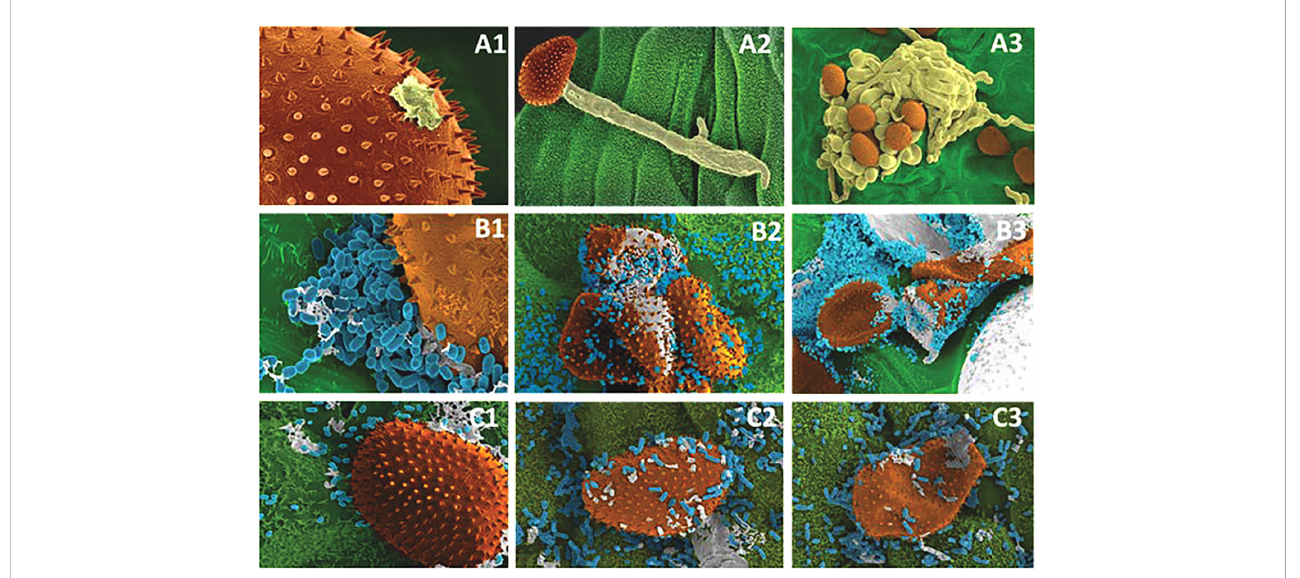
FIGURE 6 Potential antagonistic effect of Bacillus subtilis (AFS032321) and Pseudomonas_E chlororaphis (AFS000009) against Phakopsora pachyrhizi urediniospores. Healthy urediniospores: (A1) urediniospore on the surface of soybean leaf disk showing an area where the germ tube will come out [8,000X], (A2) germinated urediniospore with developed germ tube ready to penetrate soybean leaf interior [1,500X], (A3) sporulation (9 days after inoculation) [800X]. Bacterial isolates AFS000009 (B) and AFS032321 (C) colonization: (B1) and (C1) bacterial cells around urediniospore surface [6,500X], (B2) and (C2) bacterial cells destroying urediniospores (3 days after inoculation) [2,500], (B3) and (C3) destroyed urediniospores (de fl ated, 9 days after inoculation)